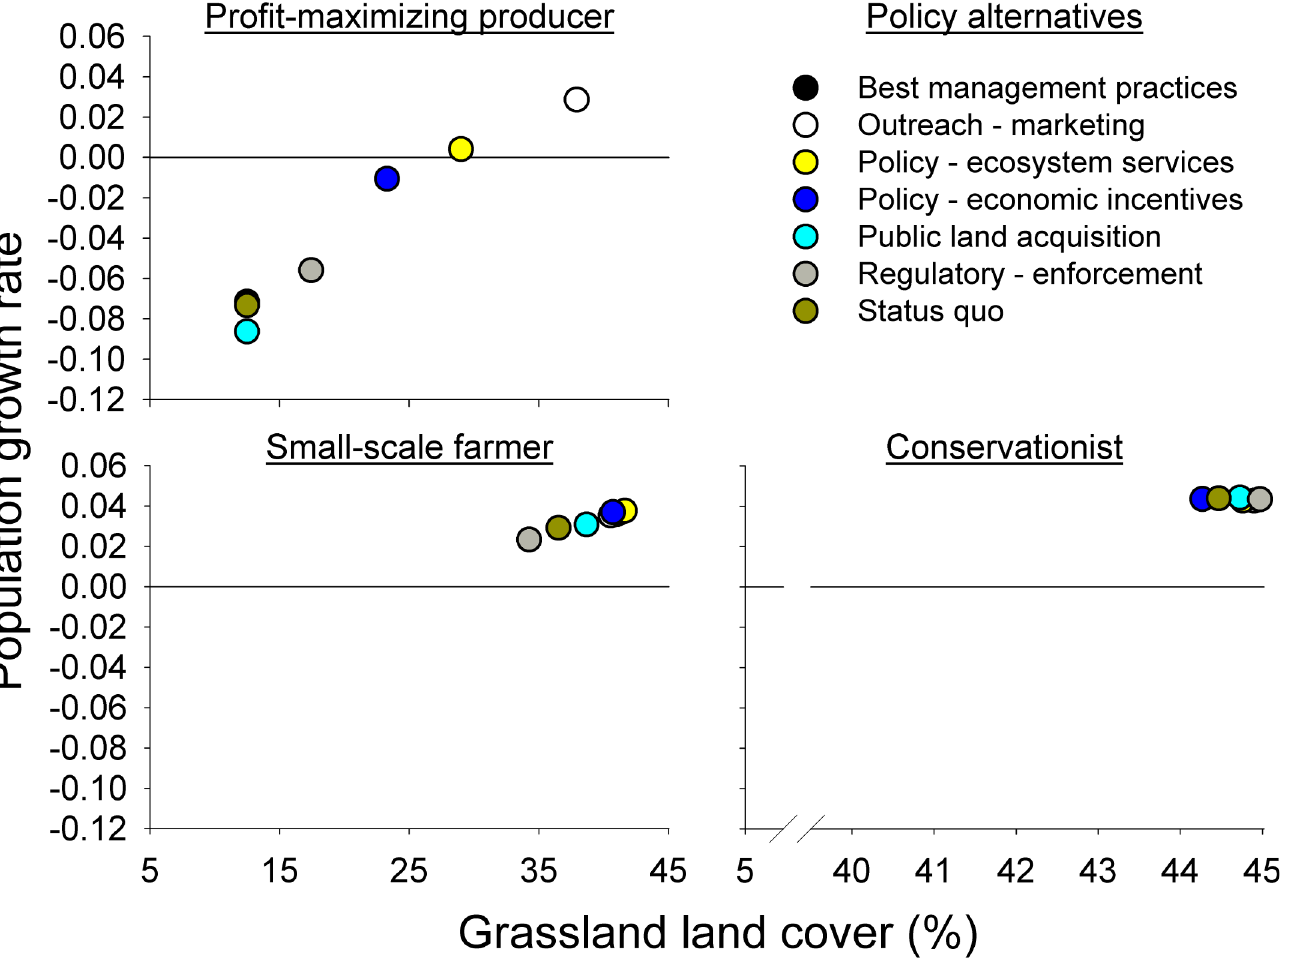
Fig 2. Resulting hypothetical grassland bird population growth rates over a 30-year time period, in response to various policy alternatives. Results indicate different potential impacts of policies, varying by landowner types, in relation to the percentage of grassland cover in the landscape.